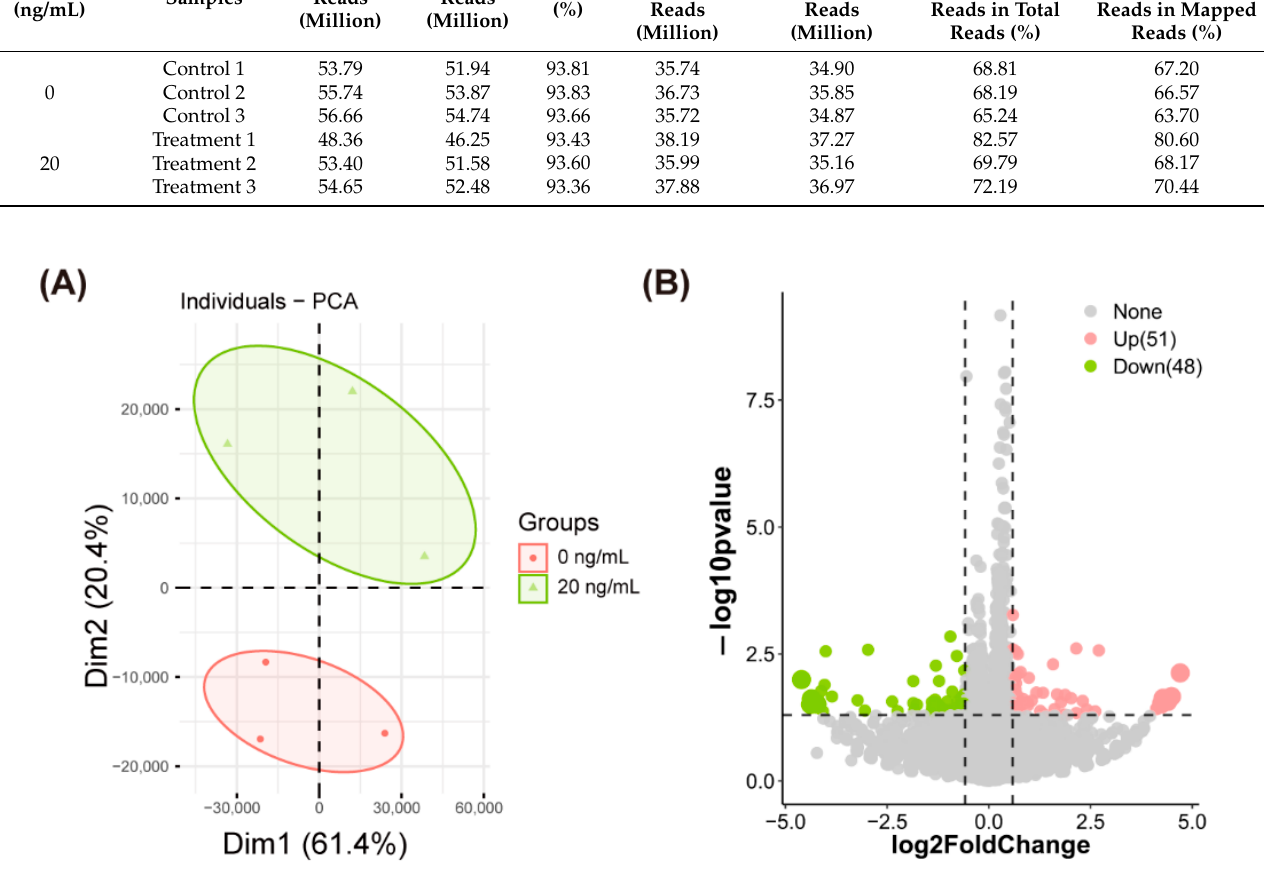
Table 5. Summary of data generated by RNA-seq of porcine oocytes of the 0 ng/mL and 20 ng/mL